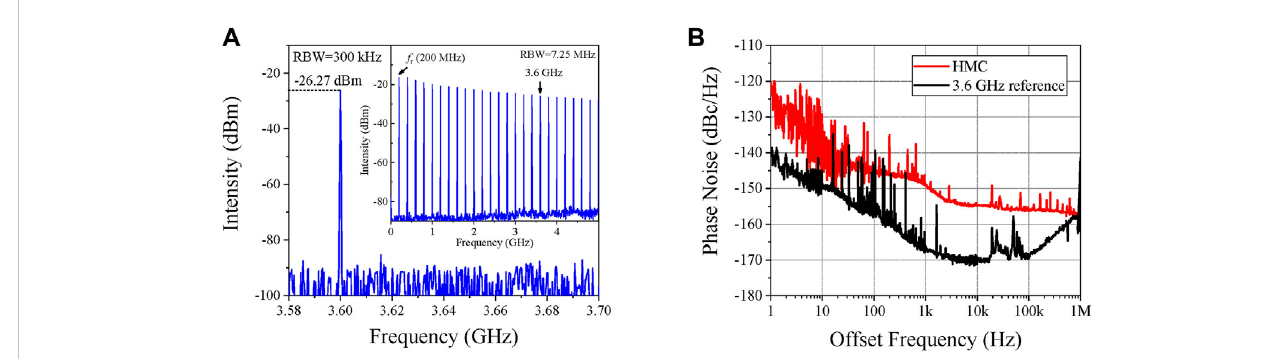
FIGURE 6 (A) Residual phase noise measurement diagram of the 3.6-GHz reference; (B) residual phase noise/instability measurement diagram; (C) frequency instability of the OFC; (D) phase noise of the free running OFC, harmonic locked OFC and out-of-loop ampli fi ed (oscillator locked) OFC; (E) residual phase noise of the